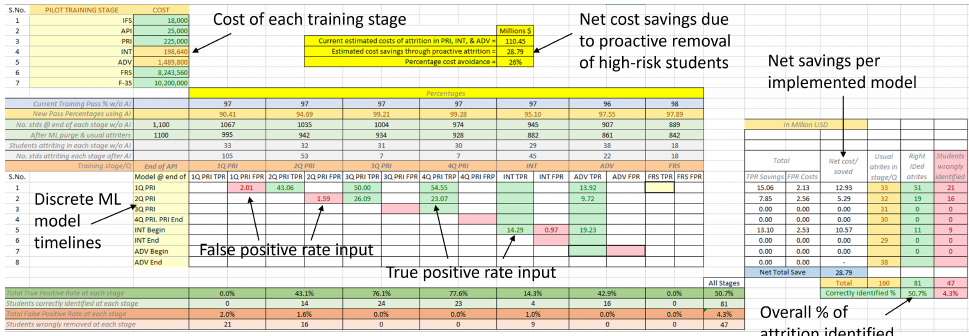
Figure 10. Attrition cost modeling and savings estimation excel tool with sample results.